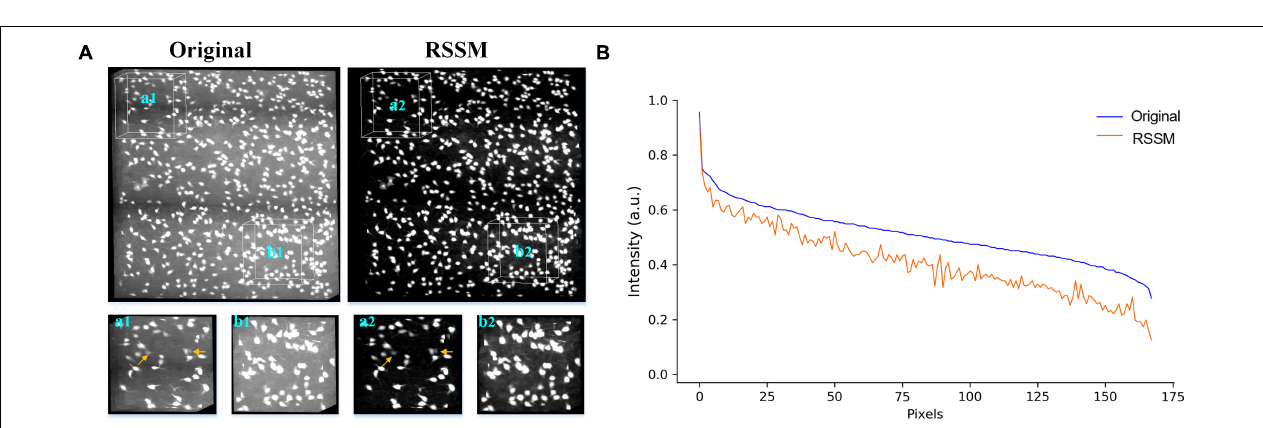
FIGURE 2 | Foreground estimation via RSSM from 3D fMOST neuronal image. (A) A neuronal image (left) and its foreground estimation (right) in 3D view. (B) 2D view of a selected slice in A (marked by green square) and its corresponding foreground estimation. (C,D) Show the image intensity distribution of the neuronal image and the estimated foreground image along a red line in (B) and traced neurite skeleton points (green lines in A ), respectively.